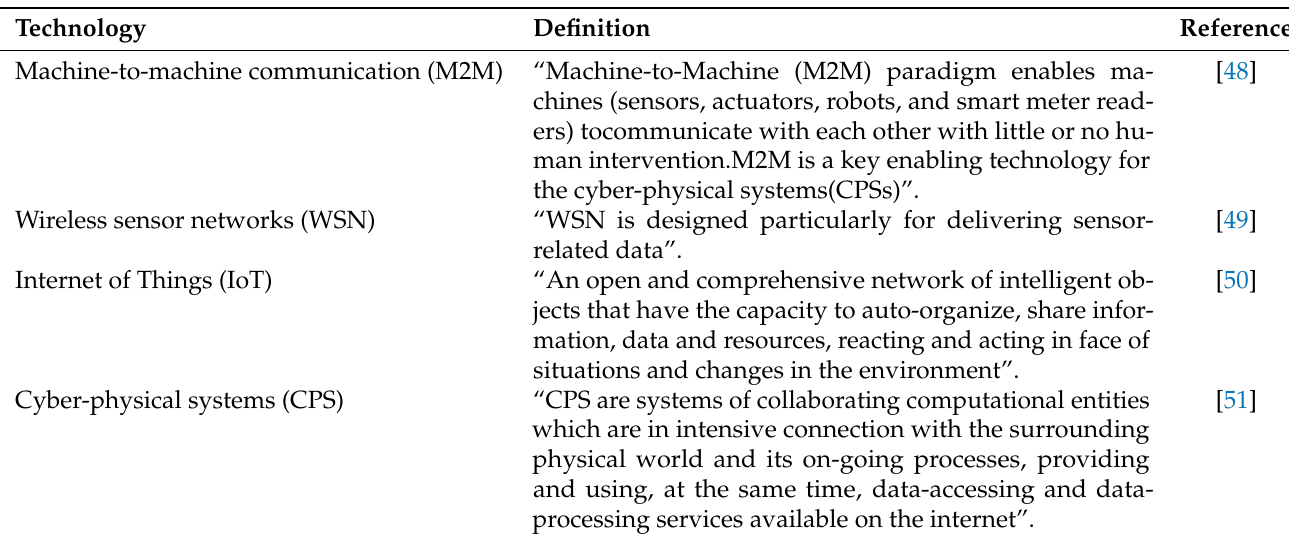
Table 1. Key technologies for Industry 4.0. For a discussion of succinct differences and commonalities between these technologies see